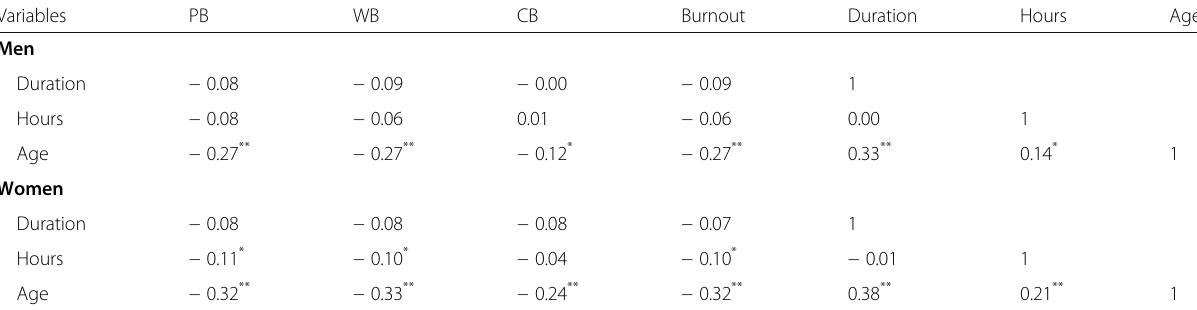
Table 3 Pearson ’ s correlation matrix between age of participants, hours worked per week, duration of employment, and burnout by gender Variables PB